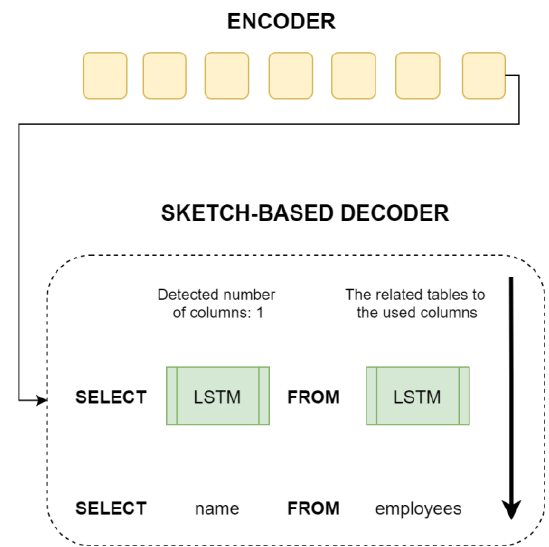
Figure.4. An example of a Sketch-based decoder. Once the number of elements is detected, we proceed with the elements prediction as it is shown in the Figure.4. Only the important parts are generated in the query and not the whole query in contrast with the sequential approach. For example, in the slot of SELECT, a sub-module is there to focus only on the columns to be generated and the same is done for the